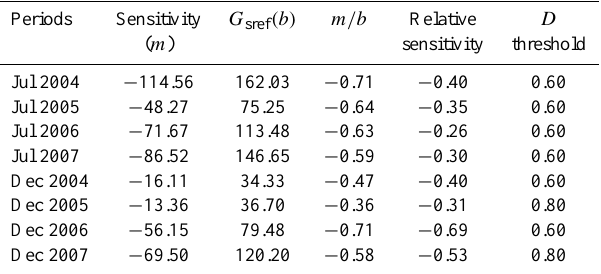
Table 3. Stomatal sensitivity to vapor pressure deficit ( D ) estimated as the slope of the relationship between canopy stomatal conduc- tance and ln( D ) (Oren et al., 1999), applied to those data in which G s decreased exponentially with D